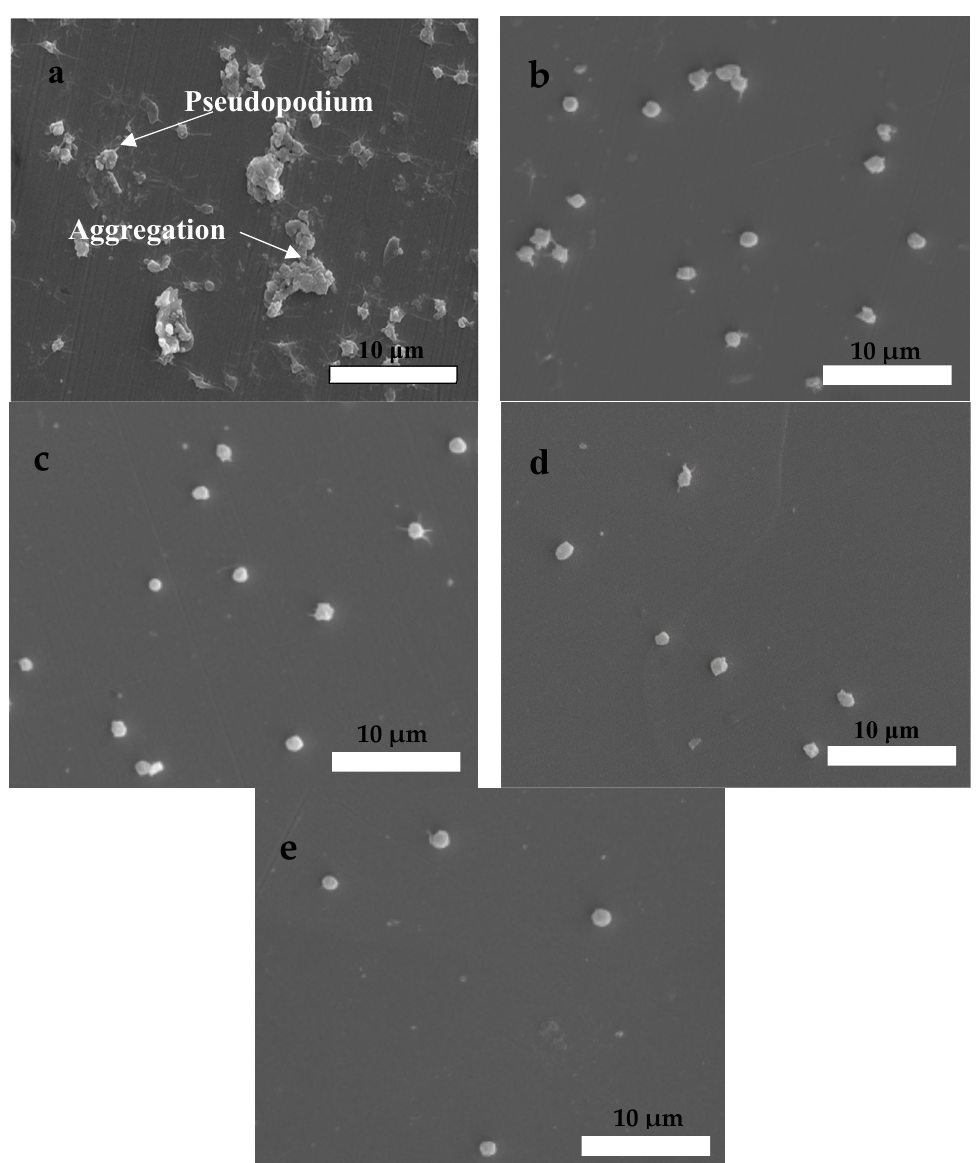
Figure 13. SEM morphologies of platelets adhered on the surface of the uncoated 316L SS and HfC coatings deposited at different bias voltages: ( a ) 316L SS, ( b ) 0 V, ( c ) − 100 V, ( d ) − 150 V, and ( e ) − 200